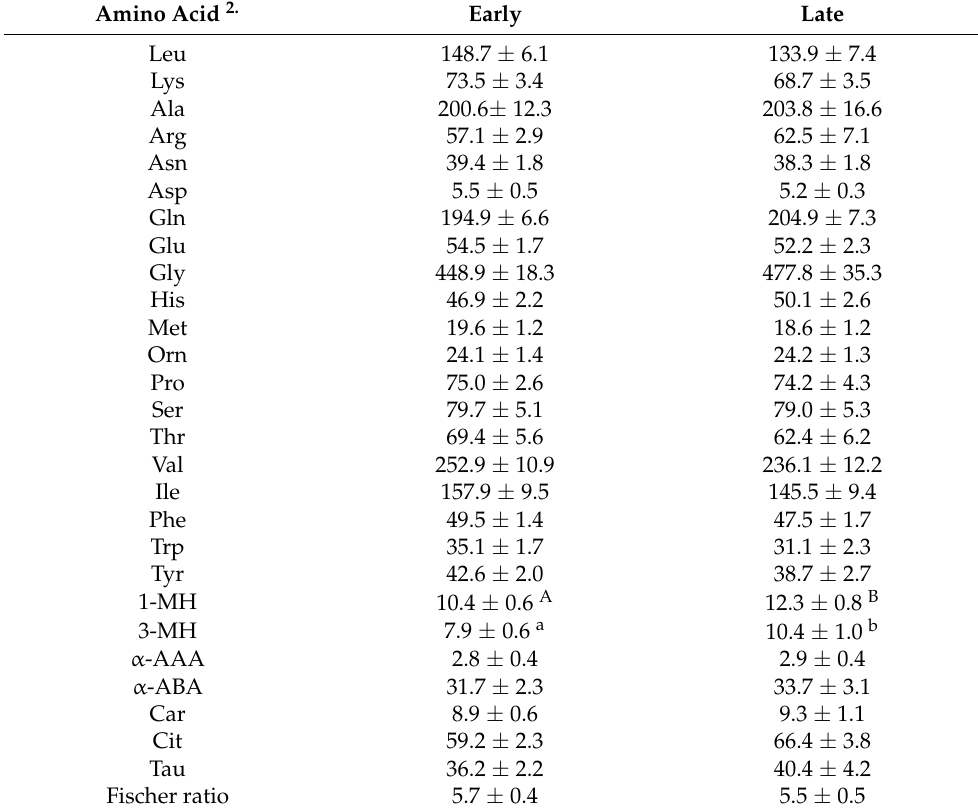
Table 1. Differences of blood amino acid concentrations (means ± SEM; nmol/mL) between the early and the late groups at 2 wk 1